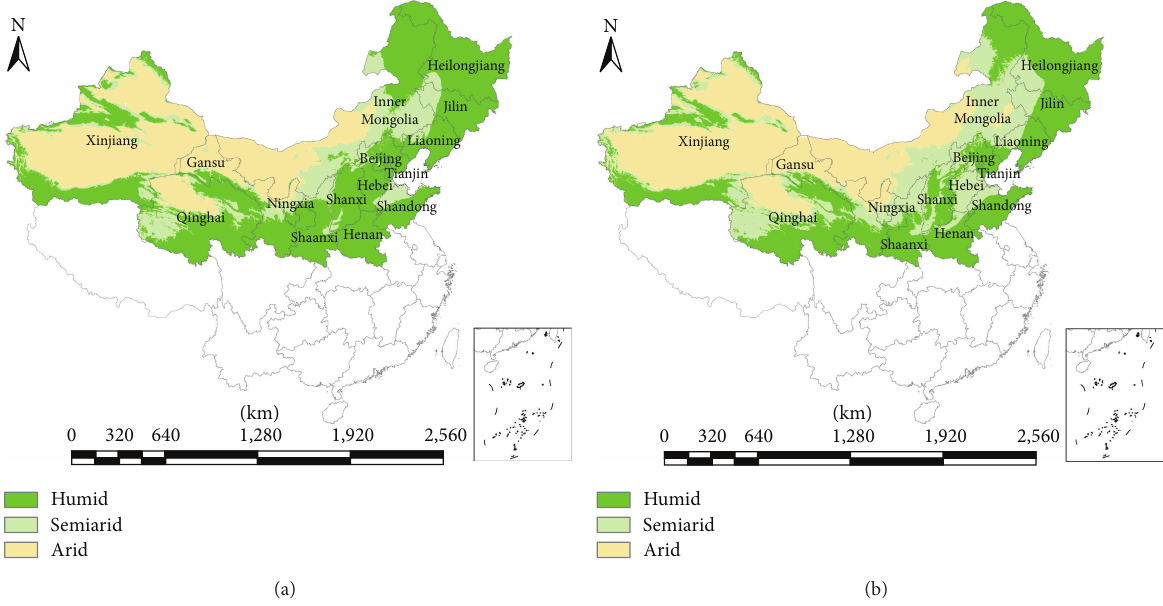
Figure 3: Humid, semiarid, and arid zones in northern China: (a) 1989 and (b) 2008.